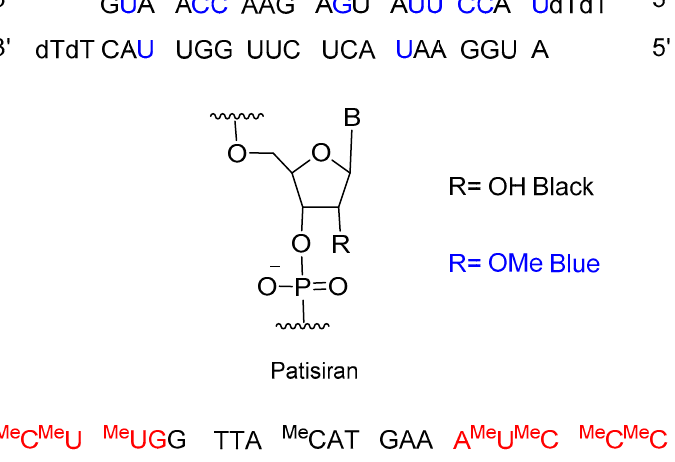
Figure 2. Structure of oligonucleotide based drugs, patisiran and inotersen.